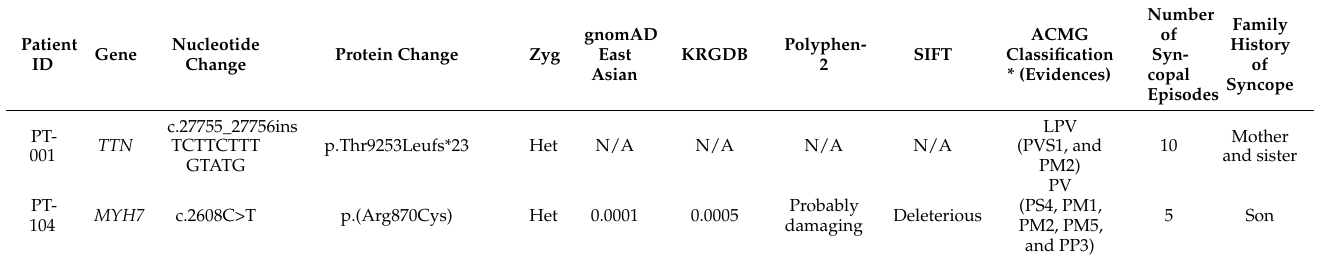
Table 3. Genetic and clinical information of patients with recurrent syncope carrying likely pathogenic